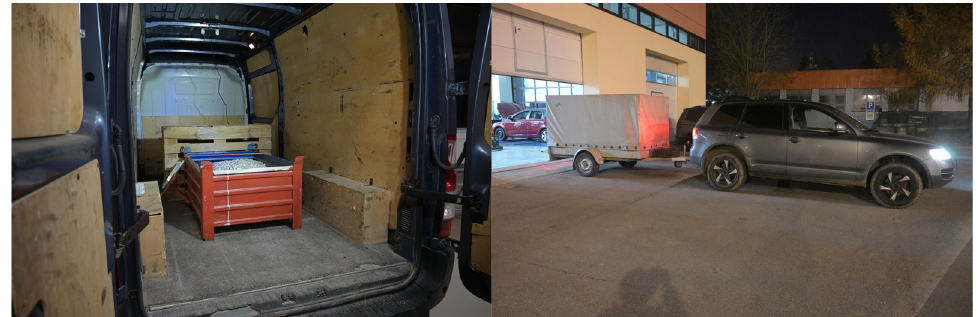
Figure 5. Van vehicle V7 ( left photo ) and vehicle combination V10 ( right photo ) used in tests. Van vehicles were tested loaded with 2 steel pallets of total mass 1000 kg (in Table 3 denoted as V5 and V7) and empty as well (V6, V8). Steel pallets with low center of gravity allowed to obtain the highest possible lateral accelerations without the vehicle tipping over. Vehicle V9 was tested without trailer and with 400 kg single axle trailer indicated as V10. Selected parameters of vehicles and position of sensor are indicated in Figure 6 and Table 3.